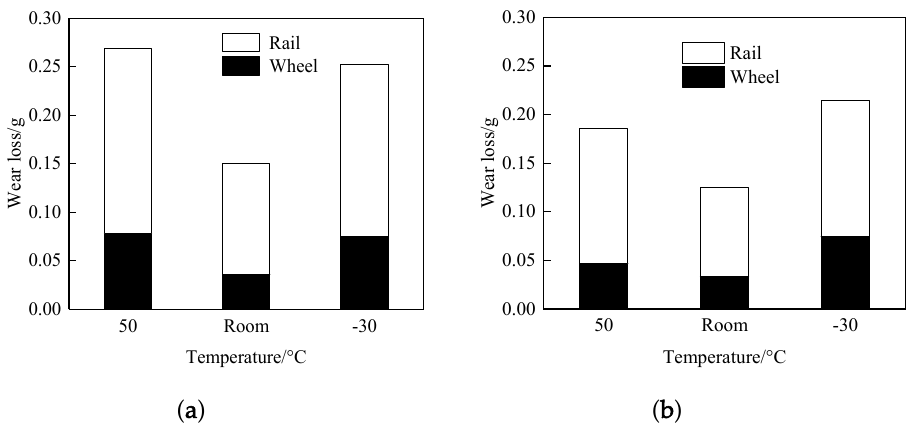
Figure 6. Wear loss of wheel/rail rollers. (a) D1; (b) D2.